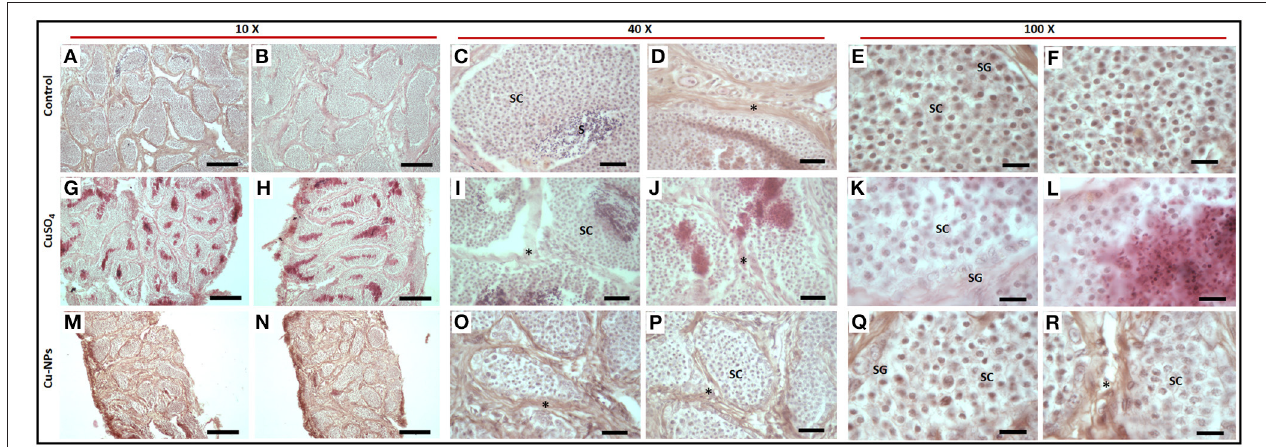
FIGURE 3 | Histology of representative control (A–F), CuSO 4 (G–L) and CU-NPs (M–R) treated testis of catfish stained with hematoxylin and eosin. * indicates basal lamina (BL); Spermatocytes (SC); Spermatogonium (SG); Sperm and/or spermatids (S). Scale bar indicates (10 × : 120 µ m; 40 × : 25 µ m and 100 × : 10 µ